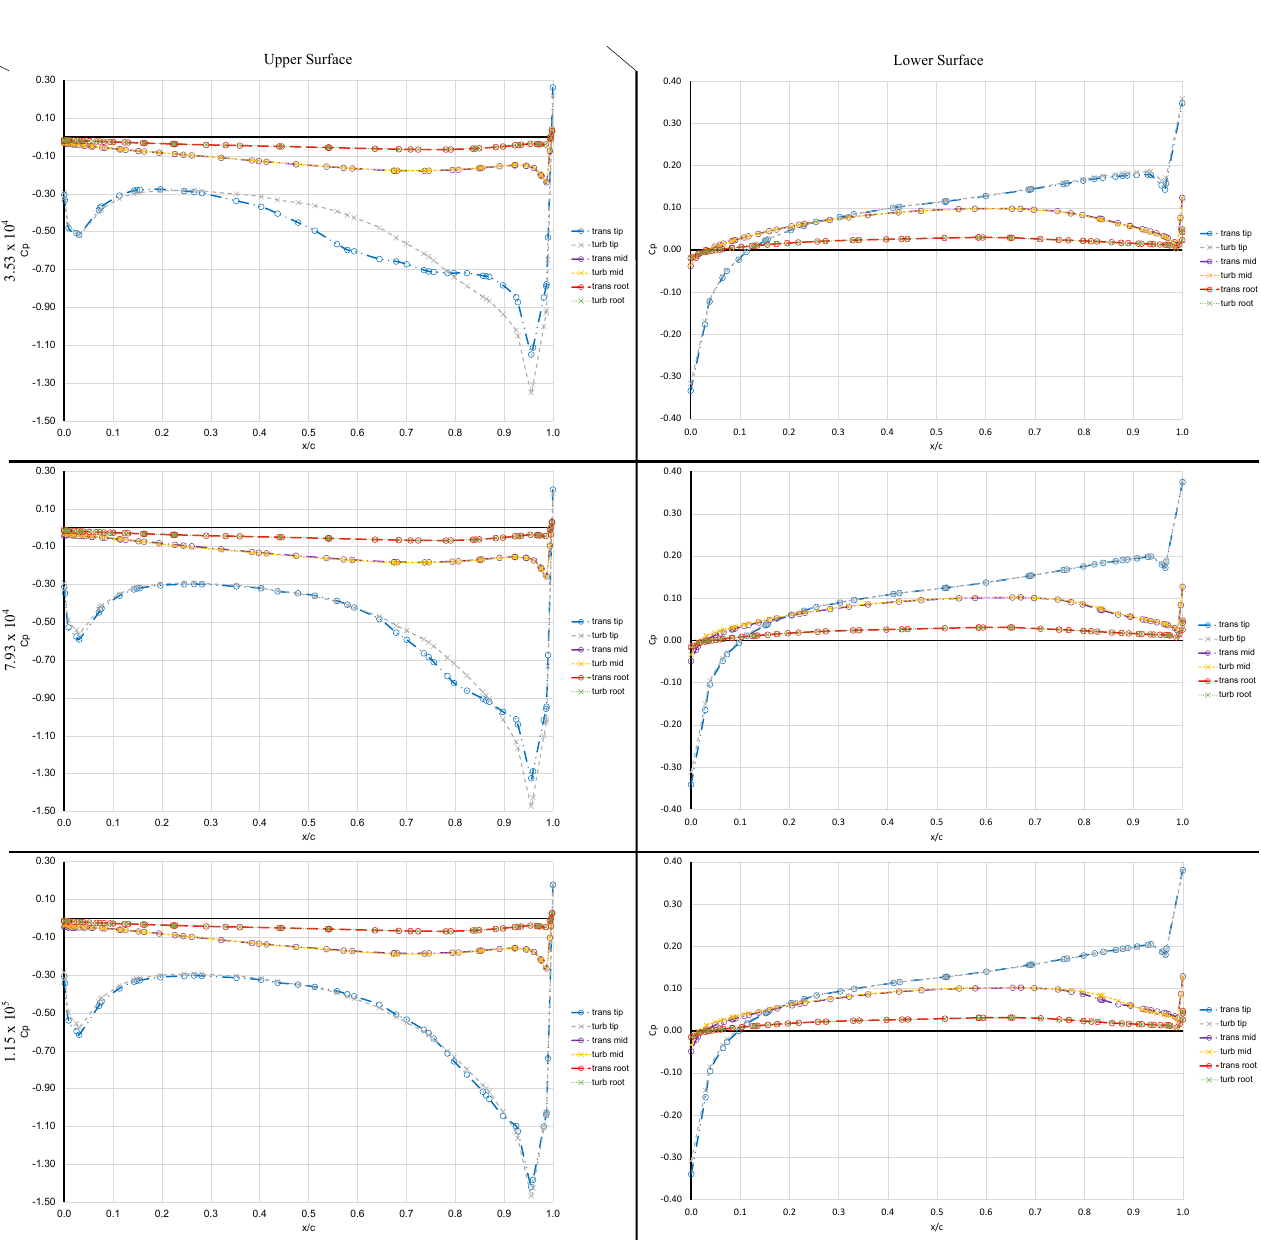
Figure 10. Pressure coefficient along the chord for different sections along the span. On the lower surface, there are no significant differences in C p between the models, since the adverse pressure gradients are not as strong as on the upper surface. It is also observed that the highest pressure develops at the leading edge and decreases along the chord until it reaches suction values on a small zone at the trailing edge. Due to the high pressure difference between the upper and lower surface at the leading edge, a pitching moment is developed on the blade. This moment could affect the performance of the blade by modifying the effective angle of attack of the section of the